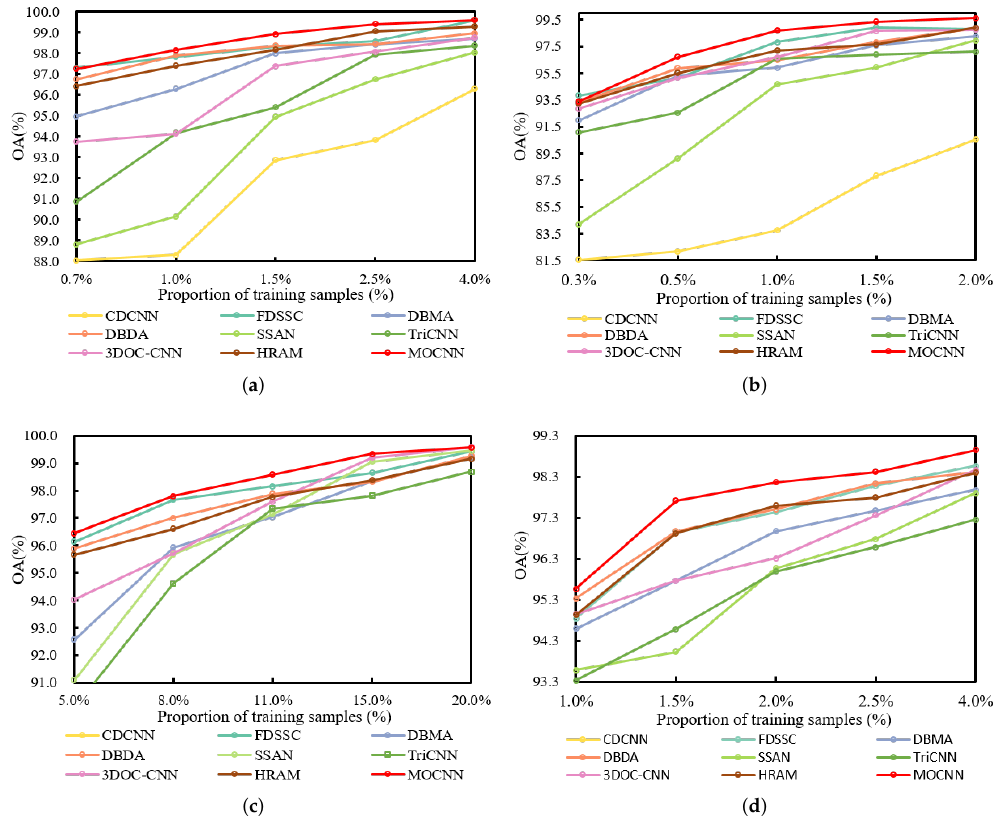
Figure 11. Classification performance under different percentages of training samples. ( a ) UP. ( b ) SV. ( c ) IN. ( d )